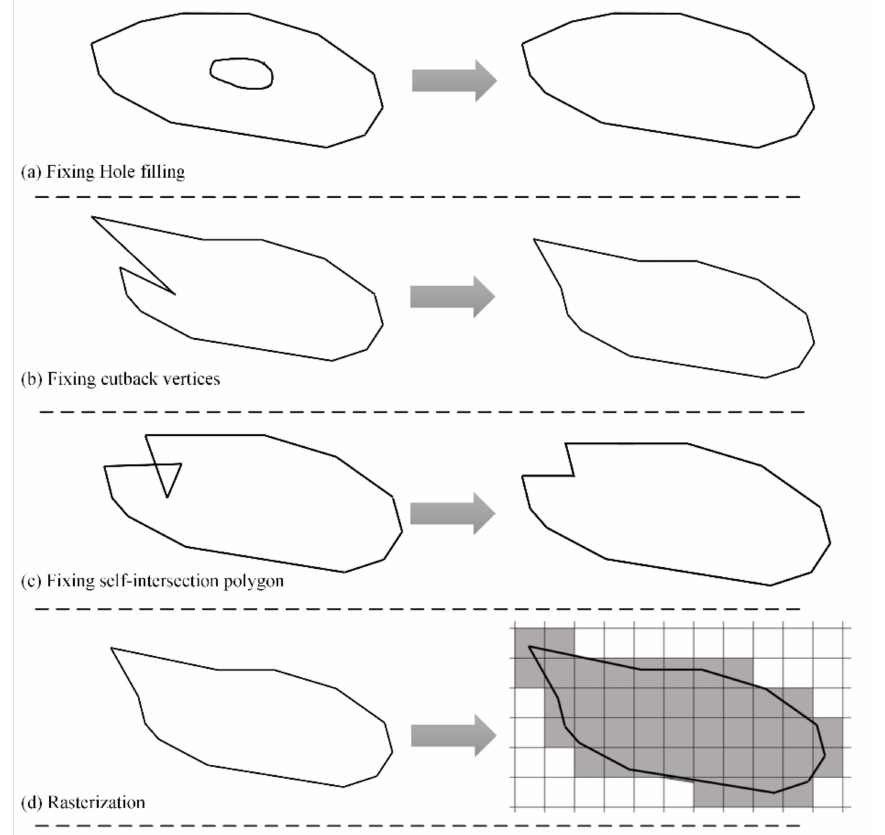
Figure 2. Schematic of preprocessing. Left: polygon before preprocessing, right: result after preprocess- ing. ( a ) Holes removal; ( b ) Removal of cutback verities; ( c ) Fixing self-intersection; ( d )